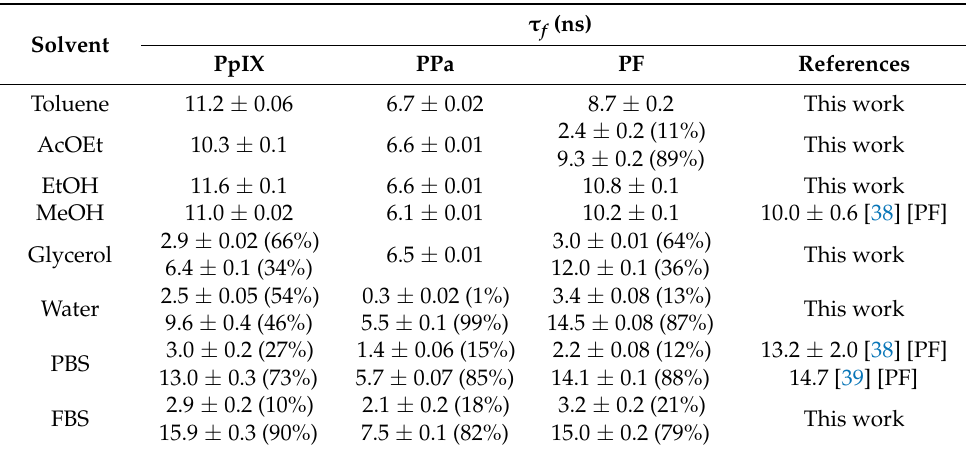
Table 4. Fluorescence lifetimes ( τ f ) of PpIX, PPa, and PF in different solvents at room temperature ( c = 1.87 µ M, λ exc = 408 nm). τ f (ns) Solvent PpIX PPa